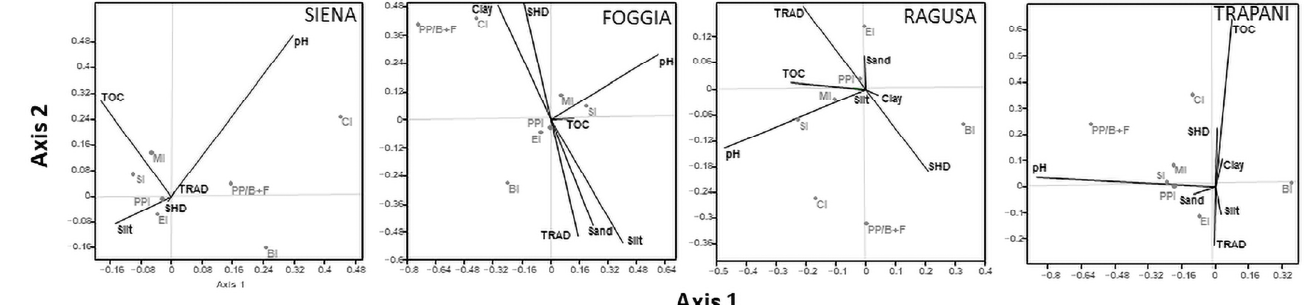
Figure 5. Scatter plots of CCA between soil properties and nematode indicators (MI, maturity index; PPI, plant-parasitic index; BI, basal index; CI, channel index; EI, enrichment index; SI, structure index; Pp/B+F, the ratio of obligate plant parasites to bacterivores and fungivores). Siena, percentage of variance explained was 29.35% for axis 2 ( p < 0.05), no significance for axis 1. Foggia, percentage of variance was 57.49% for axis 1 ( p < 0.04) and 36.75% for axis 2 ( p < 0.004). Ragusa, percentage of variance explained was 24.38% for axis 2 ( p < 0.05), no significance for axis 1. Trapani, percentage of variance was 80.91% for axis 1 ( p < 0.001) and 18.00% for axis 2 ( p < 0.007).